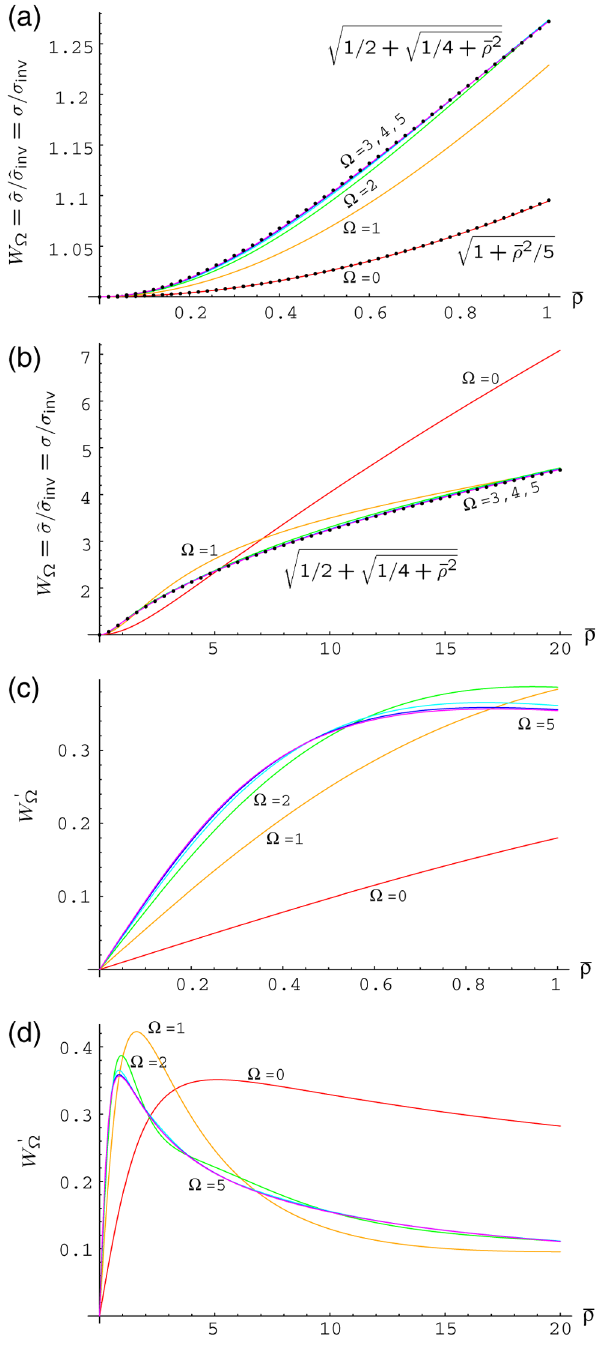
ð (cid:1) (cid:6) Þ , which repre- FIG. 1. (Color) Universal beam envelope W (cid:3) sents evolution of the invariant envelope under constant focusing in the space-charge and acceleration. Plots (a) and (b) are W (cid:3) regime ( (cid:1) (cid:6) from 0 to 1) and up to the emittance regime ( (cid:1) (cid:6) from 0 to 20), respectively. Plots (c) and (d) are the corresponding . The curves are for different values of focusing derivatives W 0 (cid:3) parameter (cid:3) , as labeled. The dots are approximate solutions with the given expressions. Clearly, the invariant envelope is unstable and transits into free expansion. For strong focusing with large (cid:3) , the approximate solution given by the potential minimum appears good all the way through the